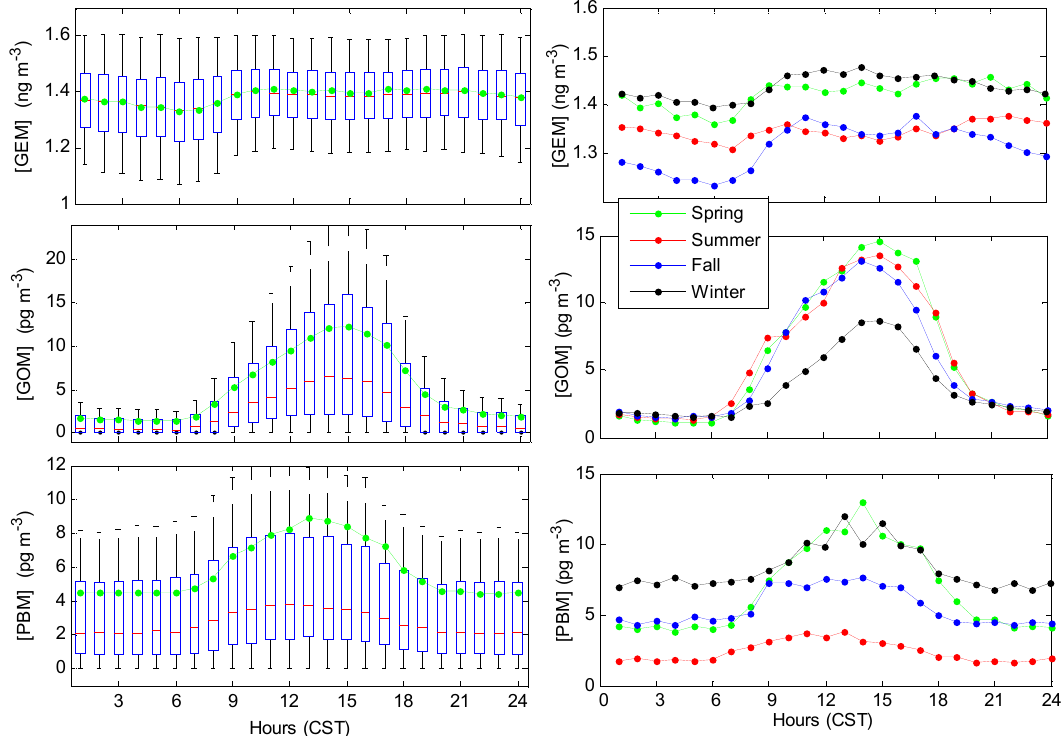
Figure 7. Left: Boxplots showing composite diurnal variations of GEM ( top ), GOM ( middle ), and PBM ( bottom ) measured at the Grand Bay site from 2007 to 2018. On each box, the central mark is the median, the edges of the box are the 25th and 75th percentiles, and the whiskers extend to the 5th and 95th percentiles. The linked green circles are hourly means. Right: Mean composite diurnal variations of GEM ( top ), GOM ( middle ), and PBM ( bottom ) for four seasons: spring (March–May), summer (June–August), fall (September–November), and winter (December–February). Times are Central Standard Time (CST).